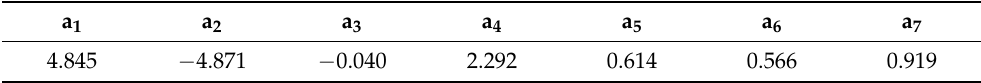
Table 5. Coefficient of the fitting formula (60°–90°).